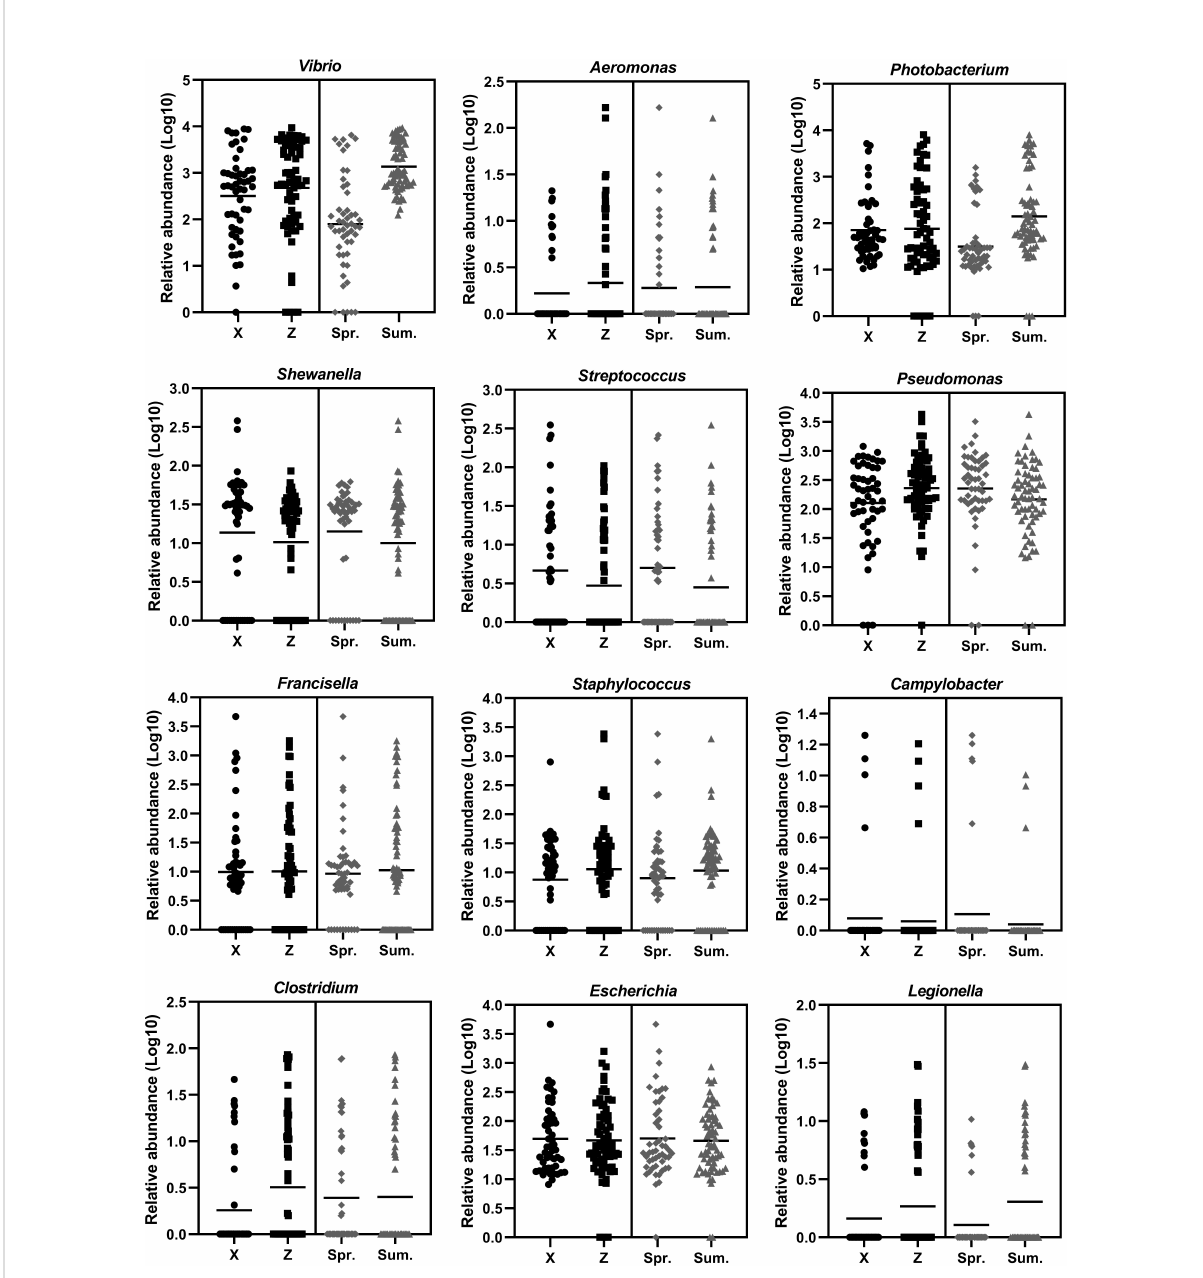
FIGURE 6 The temporal and spatial variation of the abundance of 12 genera of potential pathogenic bacteria. X indicates location X. Z indicates location Z. Spr. indicates spring. Sum. indicates